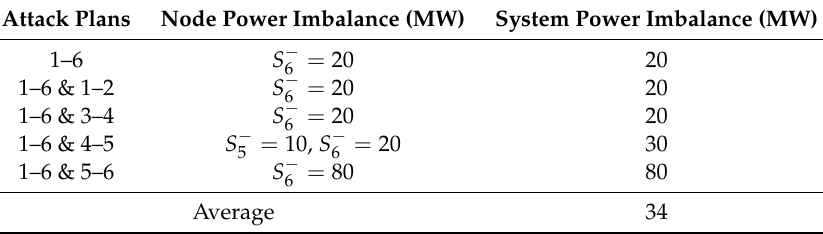
Figure 5. Intermediate systems for the deception strategy with N A = 3 and N B = 2. Table 4. System power imbalance under different attack